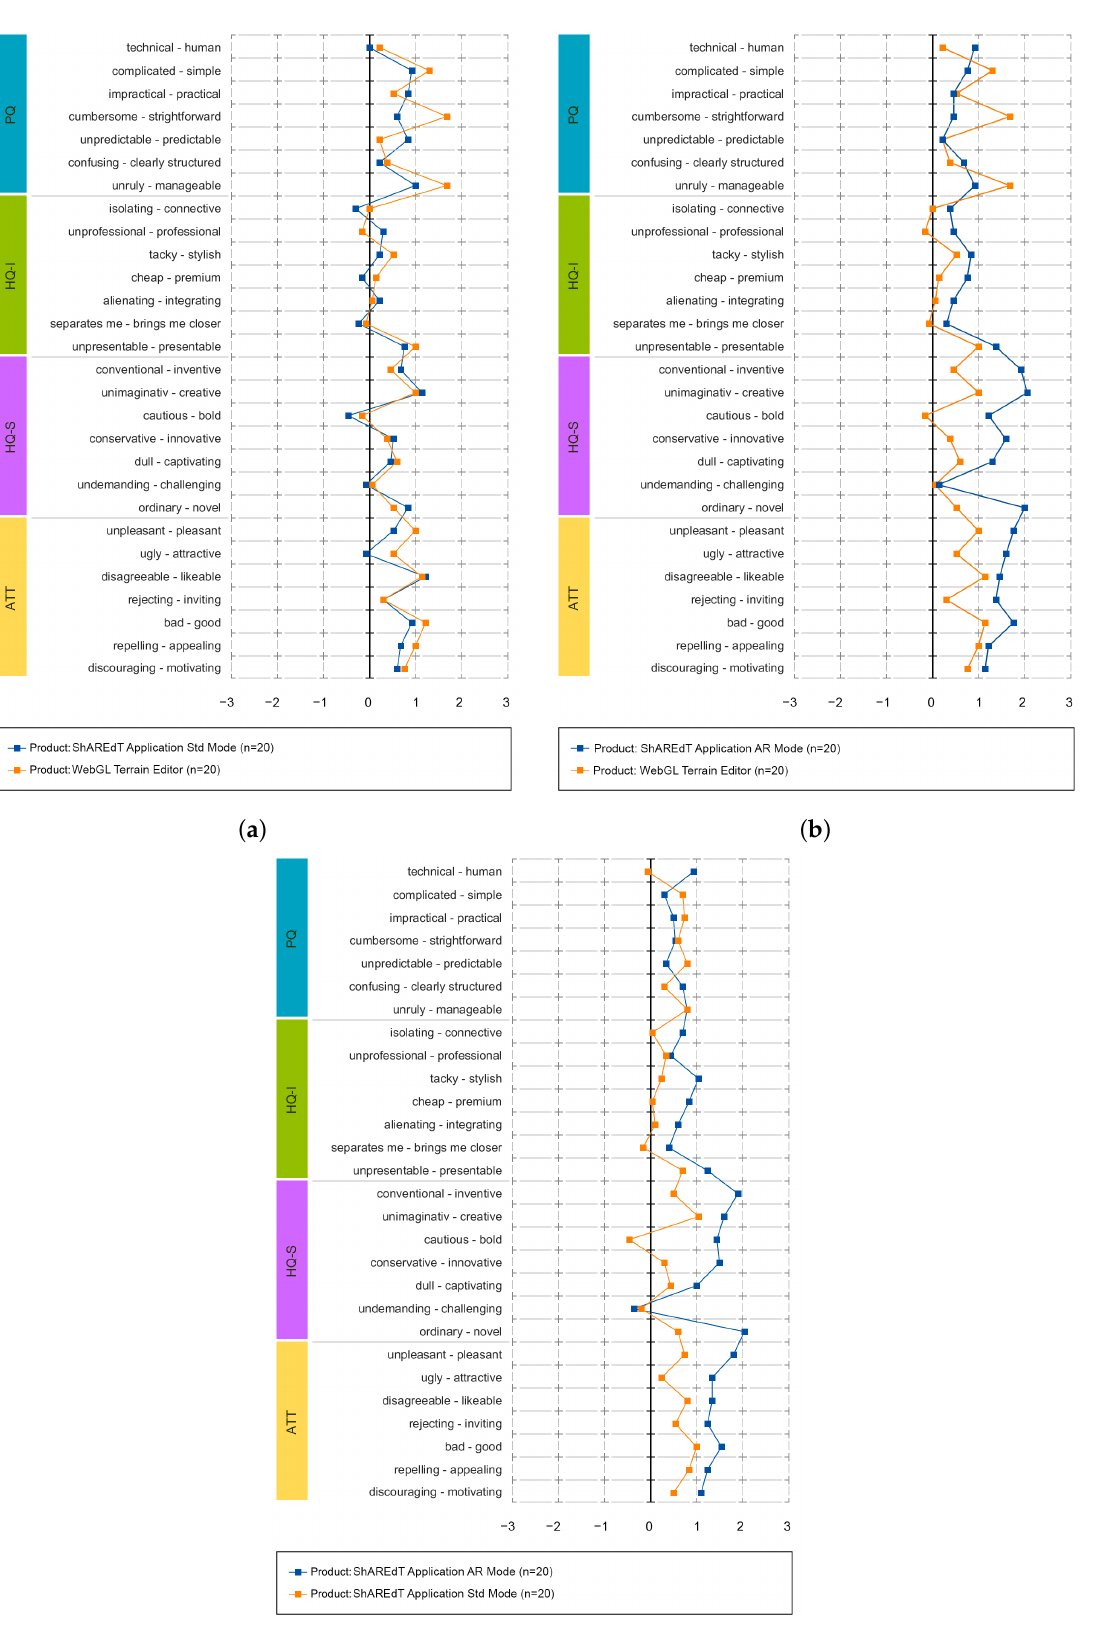
Figure 12. Semantic pairs for the three comparisons. ( a ) ShAREdT in standard mode vs. WebGL; ( b ) ShAREdT in AR mode vs. WebGL; ( c ) Standard mode vs. AR mode of